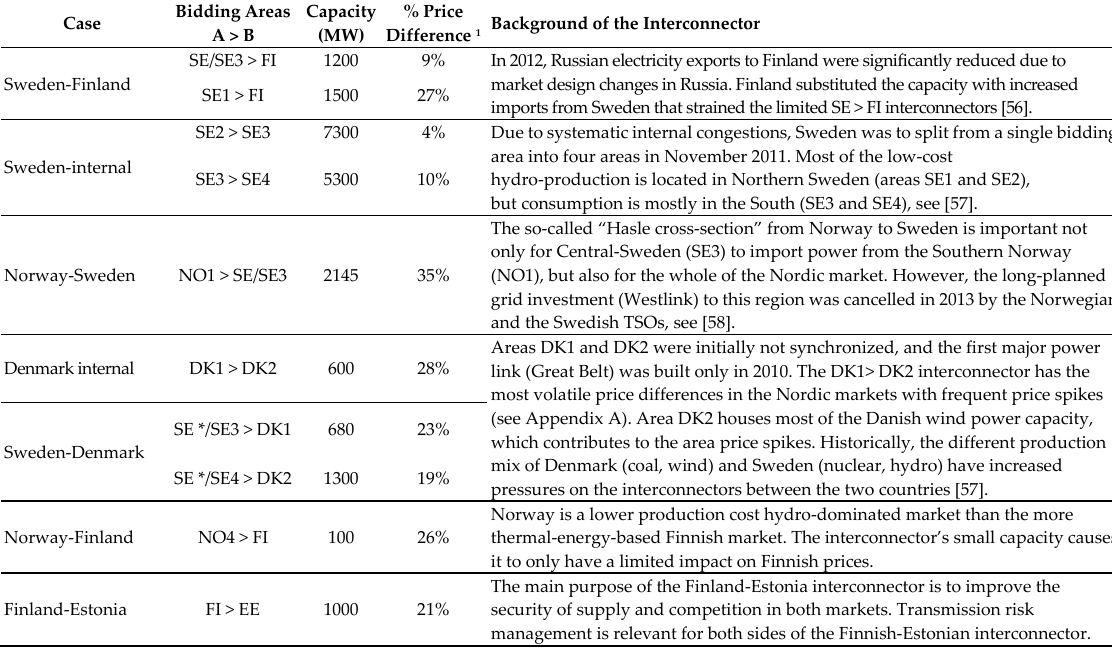
Table 2. Background of the selected